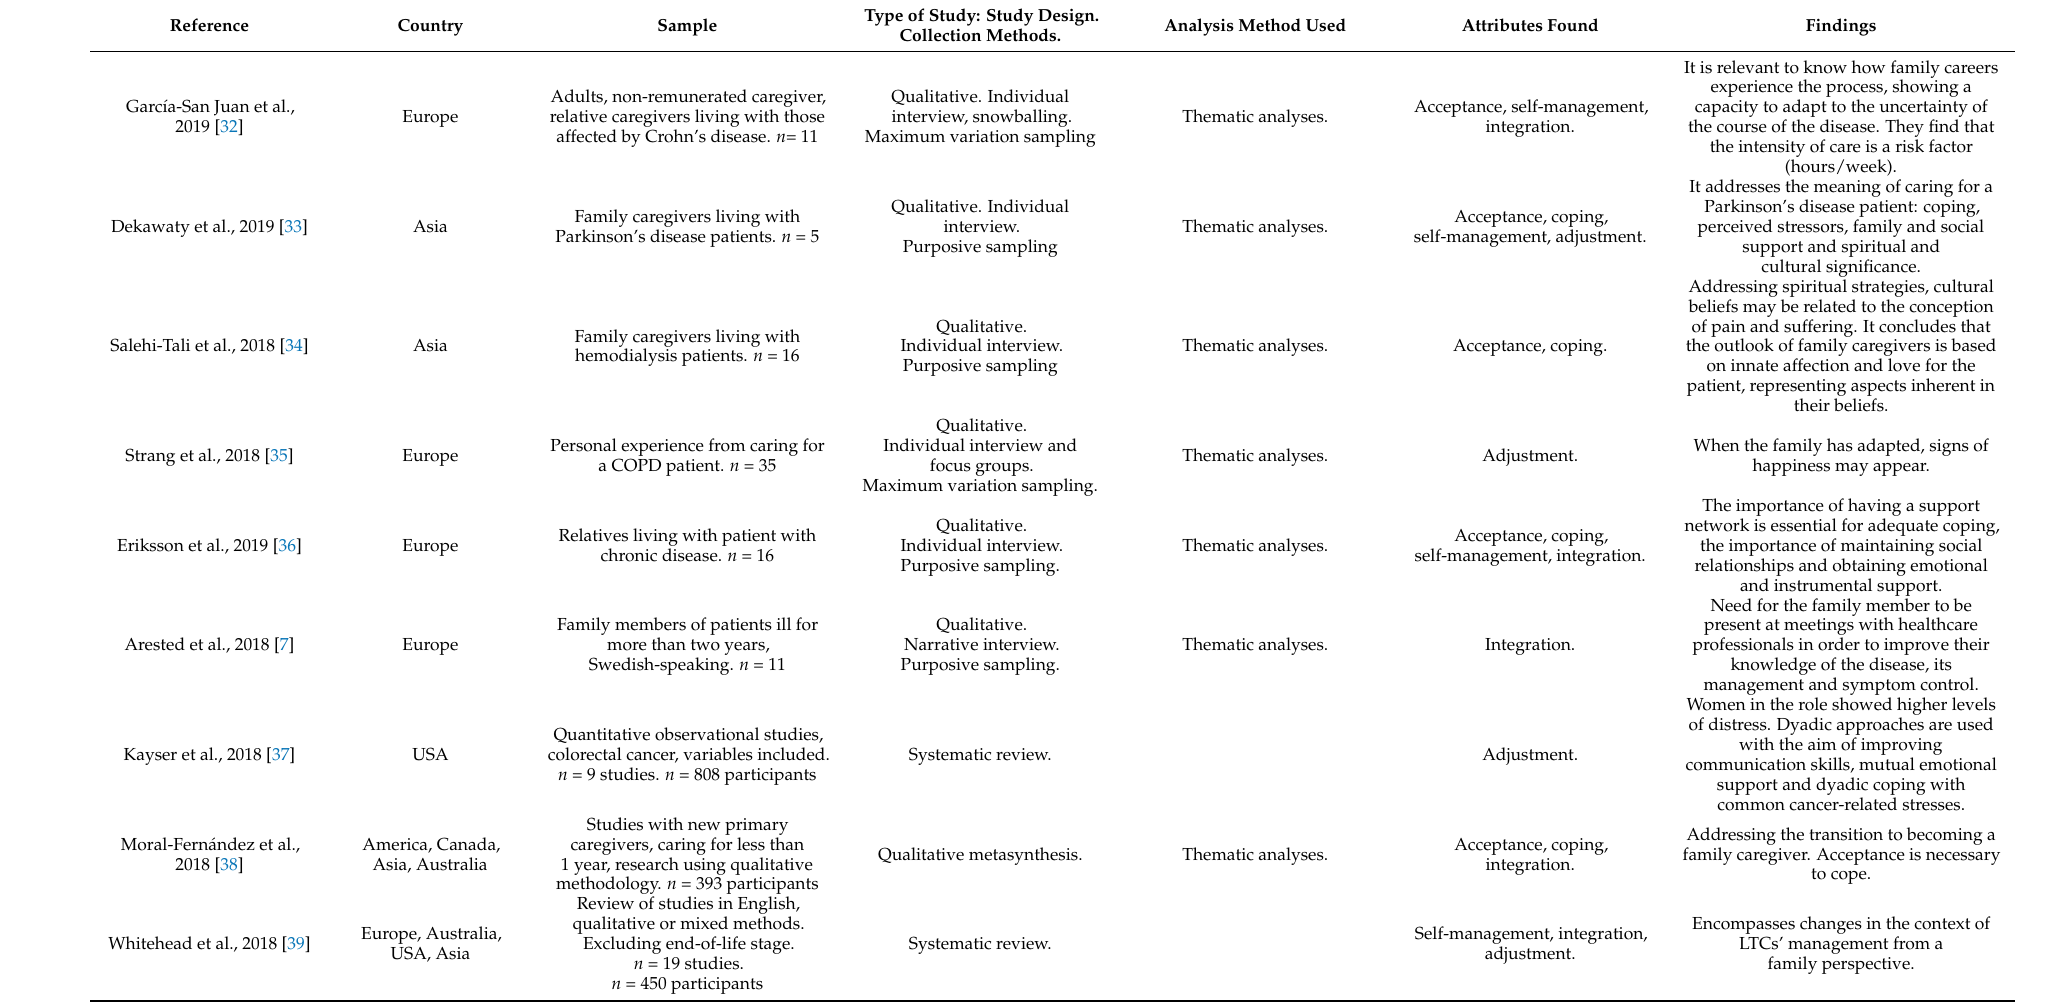
Table 4. Characteristics of included